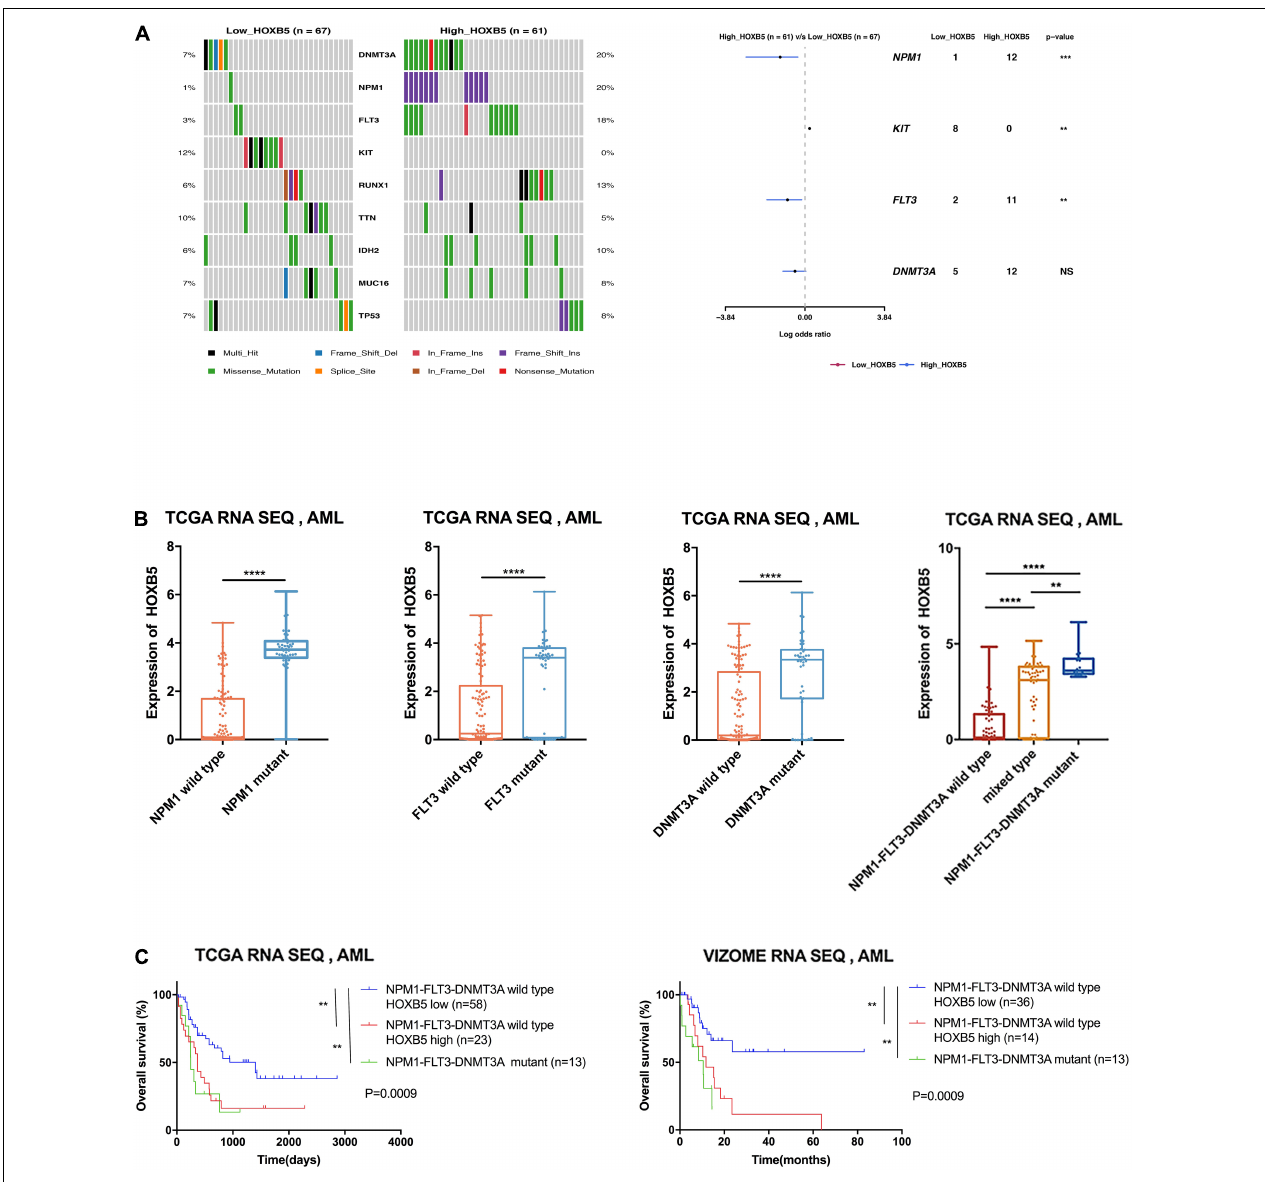
FIGURE 2 | The correlation between somatic mutation manifestation and HOXB5 expression. (A) An oncoplot and a forest plot showing differential mutant genes between low and high HOXB5 expression groups using TCGA database. (B) The difference of HOXB5 expression between mutant and wild type in TCGA database (NPM1 wild type n = 128, NPM1 mutant n = 48; FLT3 wild type n = 127, FLT3 mutant n = 49; DNMT3A wild type n = 133, DNMT3A mutant n = 43; NPM1-FLT3-DNMT3A wild type n = 89; mixed type n = 73; NPM1-FLT3-DNMT3A mutant n = 14; with t test). (C) Survival curves showing HOXB5 expression correlated with significant prognosis in patients with NPM1-FLT3-DNMT3A wild type (with log-rank test). NS, no significance. ** P < 0.01, *** P < 0.001, and **** P <